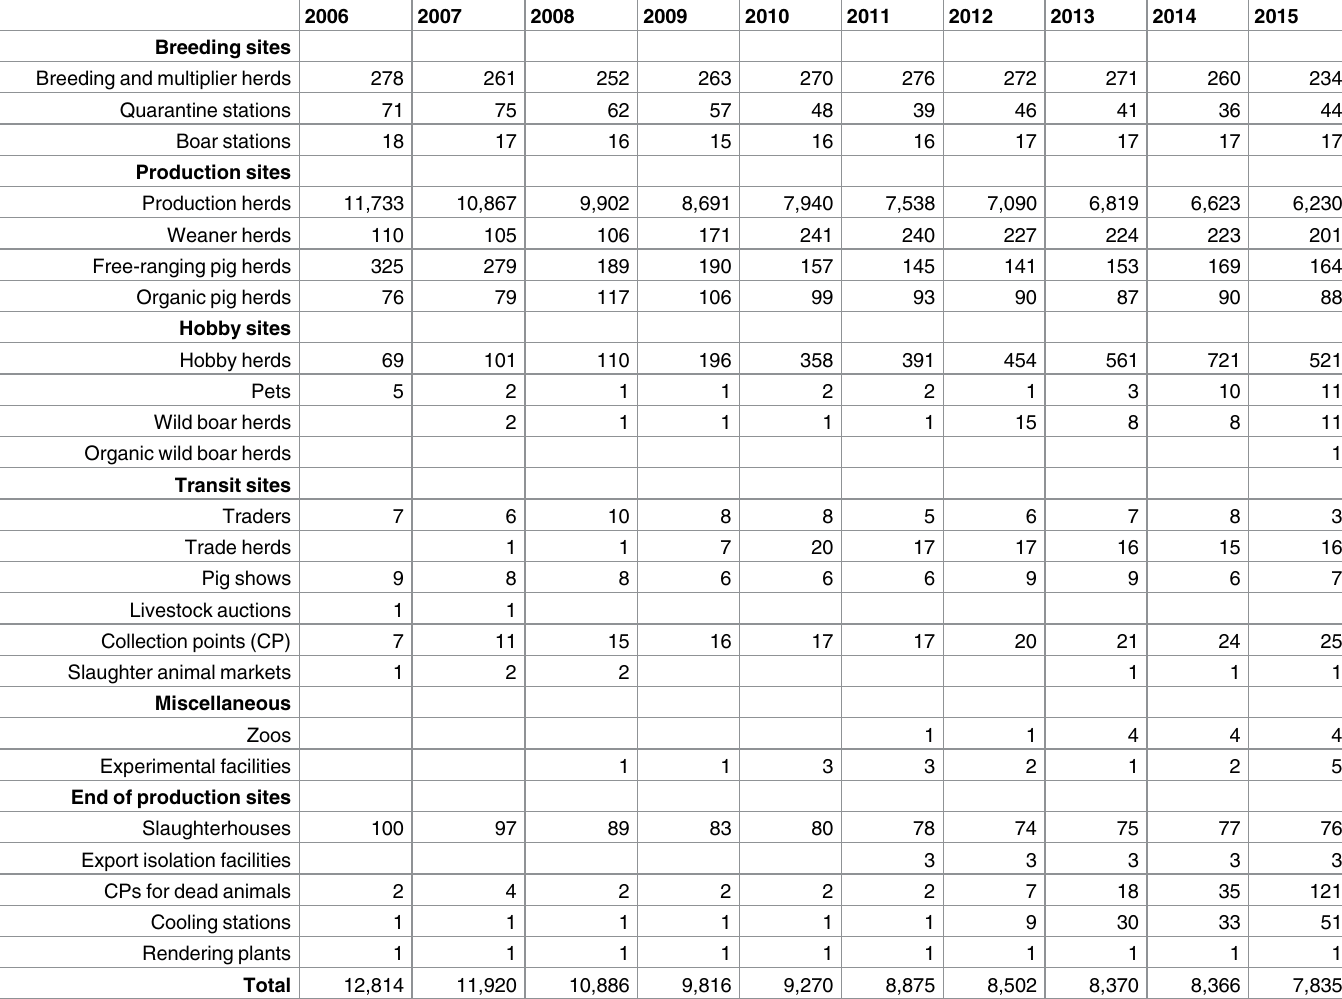
Table 1. Number of active Danish pig holdings.